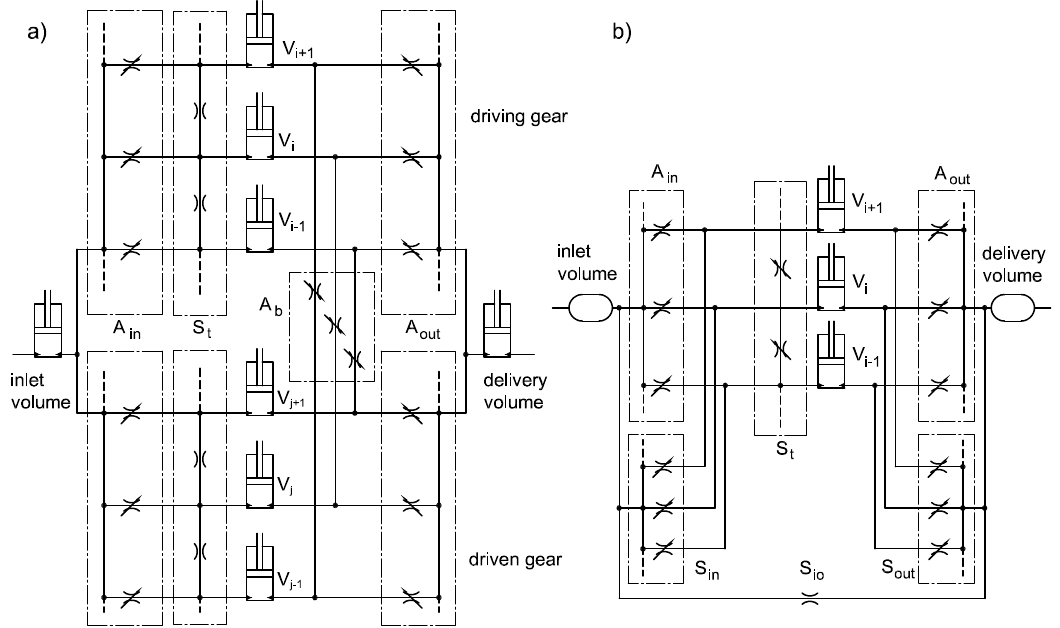
Figure 8. ( a ) Equivalent hydraulic circuit based on the SC model for an external gear pump; ( b ) circuit for gerotor pump.